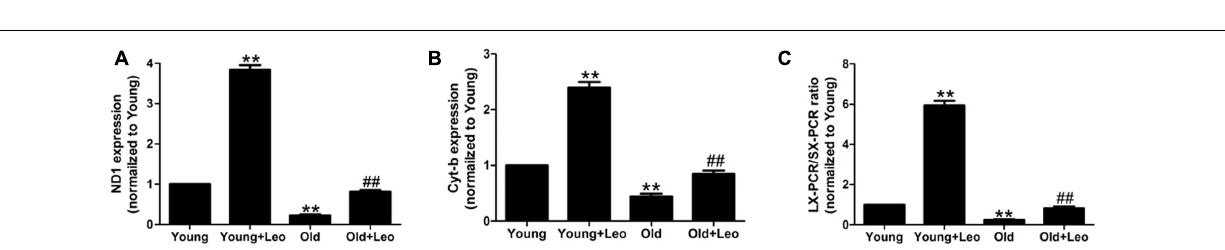
Frontiers in Pharmacology |